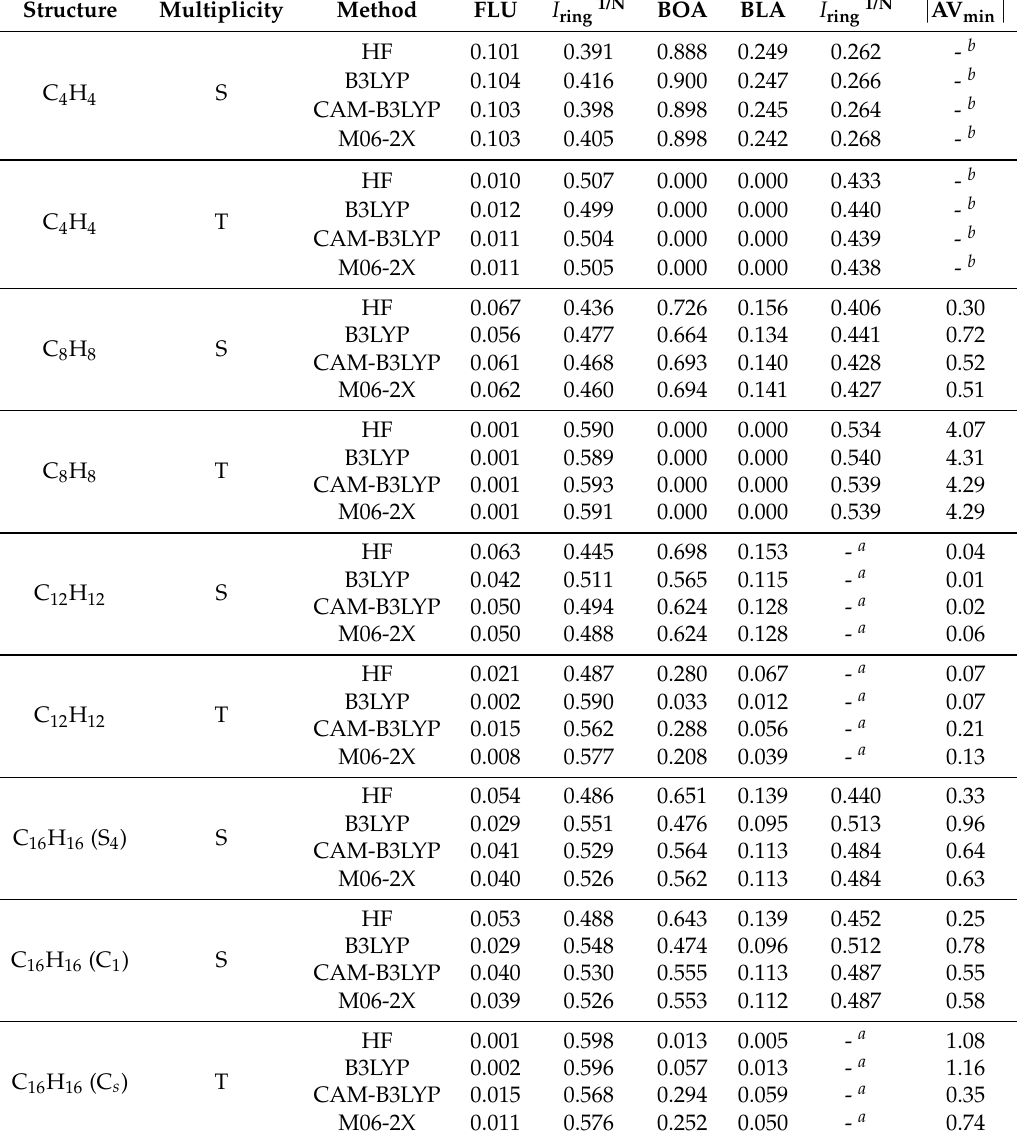
Table 2. Aromaticity indices for the studied 4 n annulenes calculated with HF, B3LYP, CAM-B3LYP, and M06-2X and the 6-311G(d,p) basis set. a I ring values were too small for an accurate calculation of I ring 1/N . b AV min cannot be calculated for rings with less than six